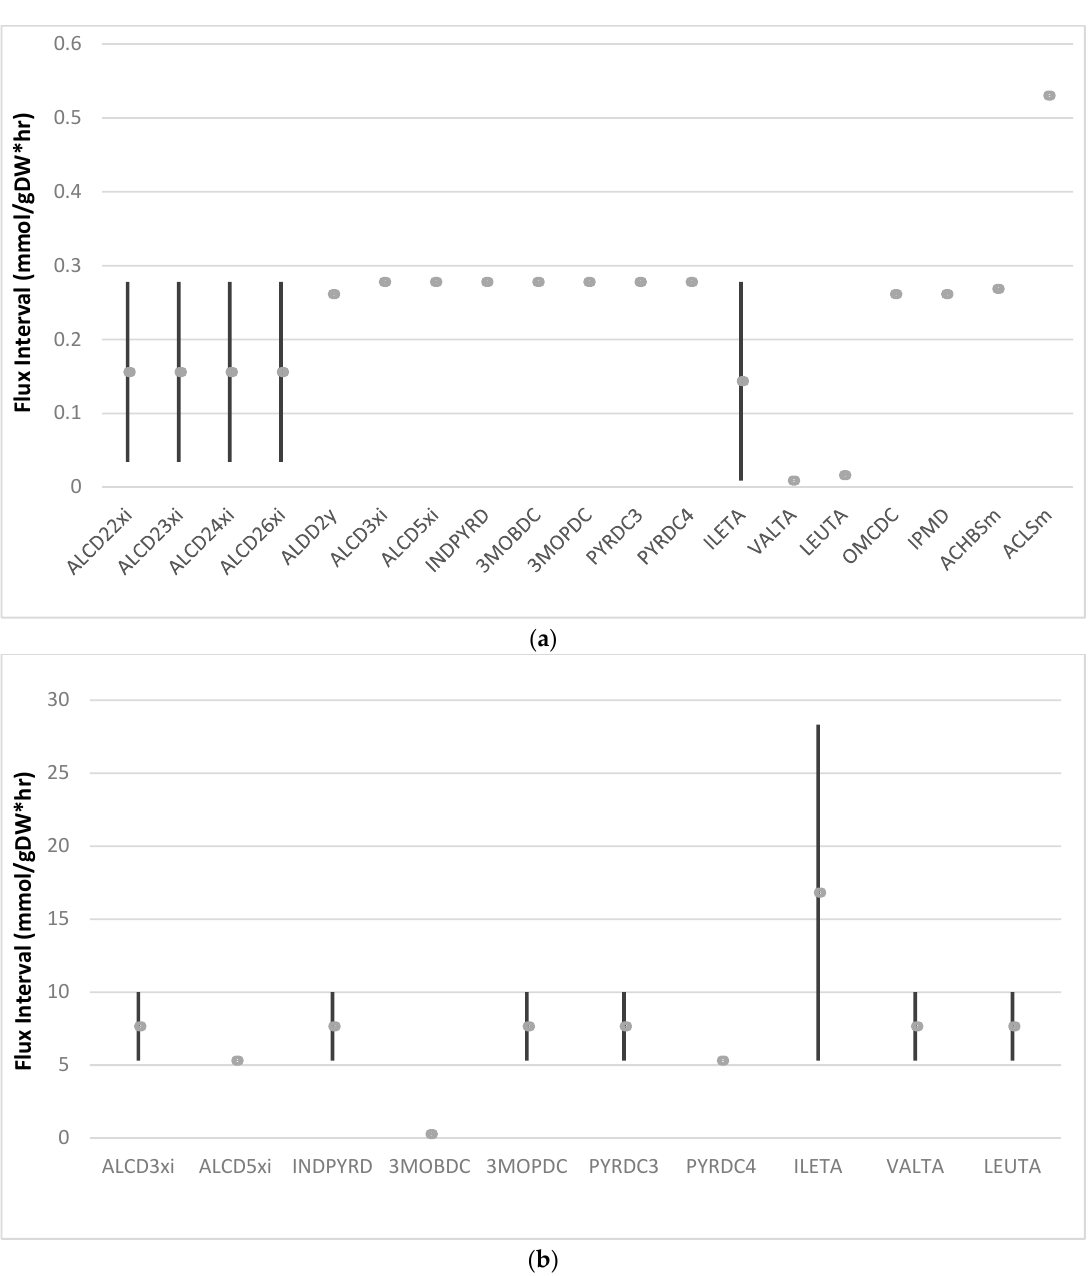
Figure 5. Flux spans for Group I fluxes for the optimal production of aroma impact fluxes represent conditions Case I where uptake fluxes are constrained based on experimental data (( a ), top) and unconstrained conditions (( b ), bottom). Bars depict the possible range (minimum and maximum) fluxes (mmol gDW − 1 h − 1 ) and dot indicates the average flux calculated by flux variability analysis (FVA) for reactions.